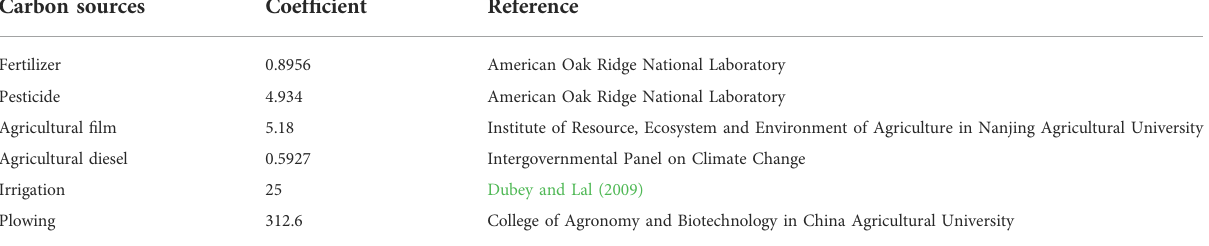
TABLE 1 Agricultural carbon sources, carbon emission coef fi cient and reference sources.